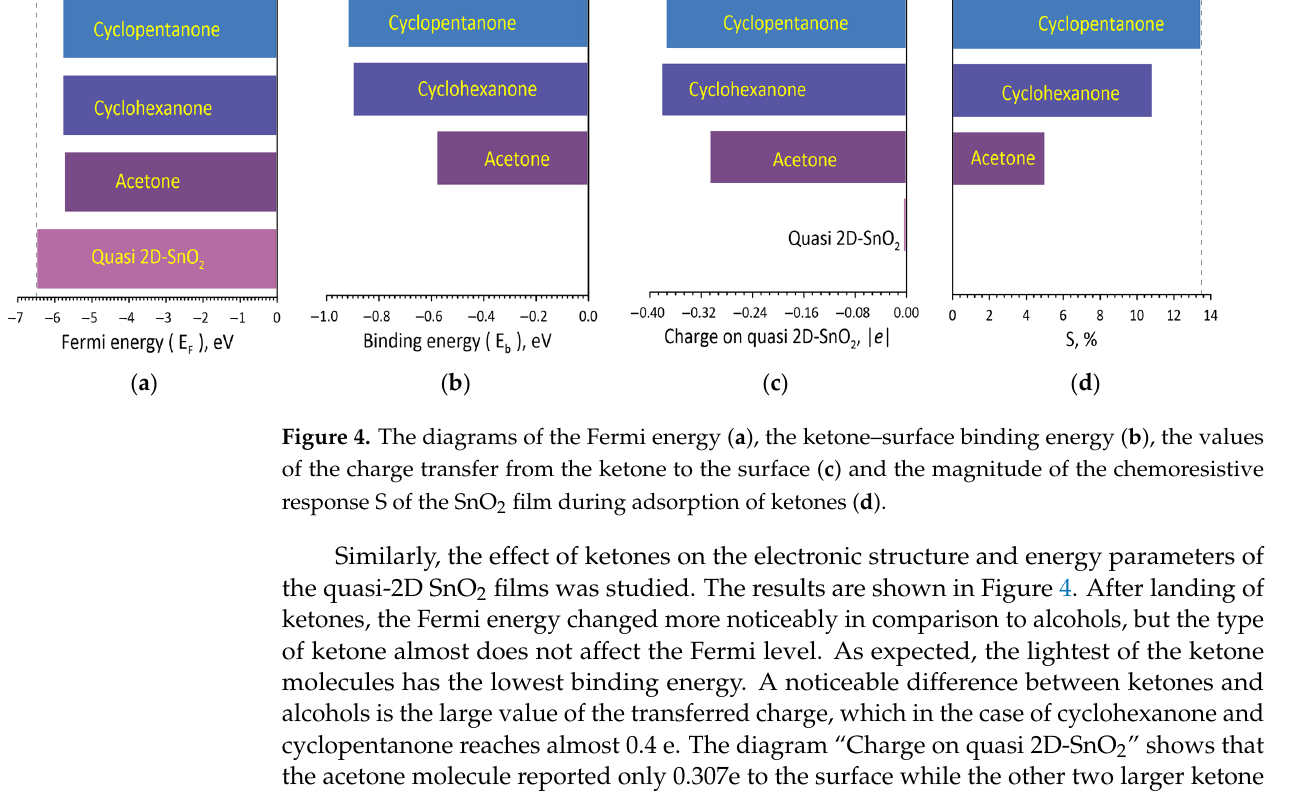
Figure 3. The diagrams of the Fermi energy ( a ), the alcohol–surface binding energy ( b ), the values of the charge transfer from the alcohol to the surface ( c ) and the magnitude of the chemoresistive response S of the quasi ‐ 2D SnO 2 thin films during adsorption of alcohols ( d ).